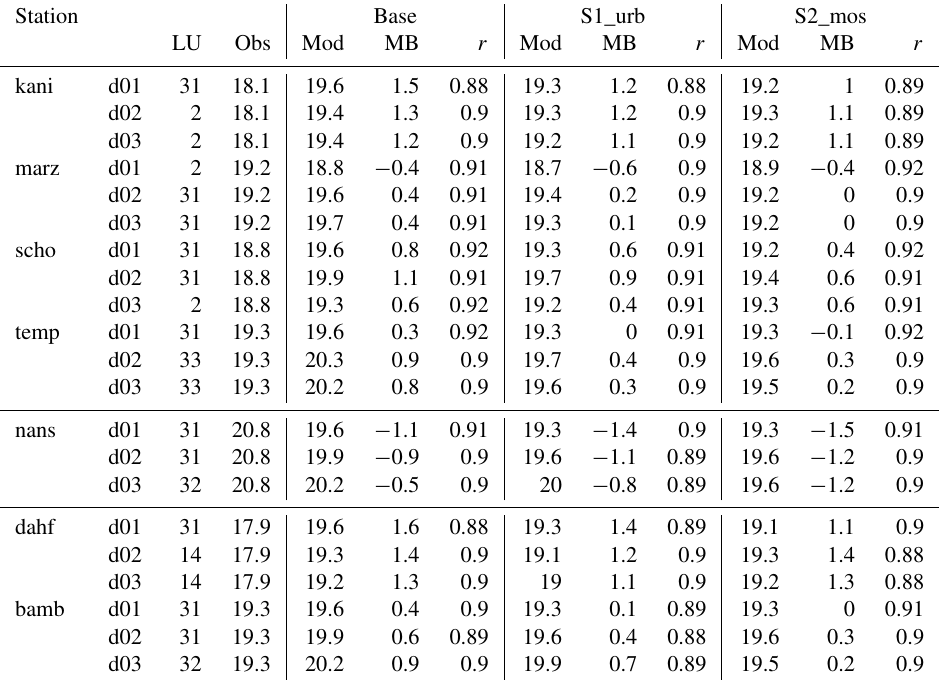
Table 4. Statistics of hourly 2m temperature for JJA for stations, where the land use class of the respective grid cell changes with resolution. “LU” refers to the WRF land use class of the grid cell in the respective domain, “Obs” refers to the JJA observed mean, “Mod” refers to the JJA modelled mean for the respective grid cell. MB is the mean bias for JJA and r is the correlation of hourly values. Obs, Mod and MB are in ◦ C. The statistics are shown for the results from the model domains of 15km (d01), 3km (d02) and 1km (d03) horizontal